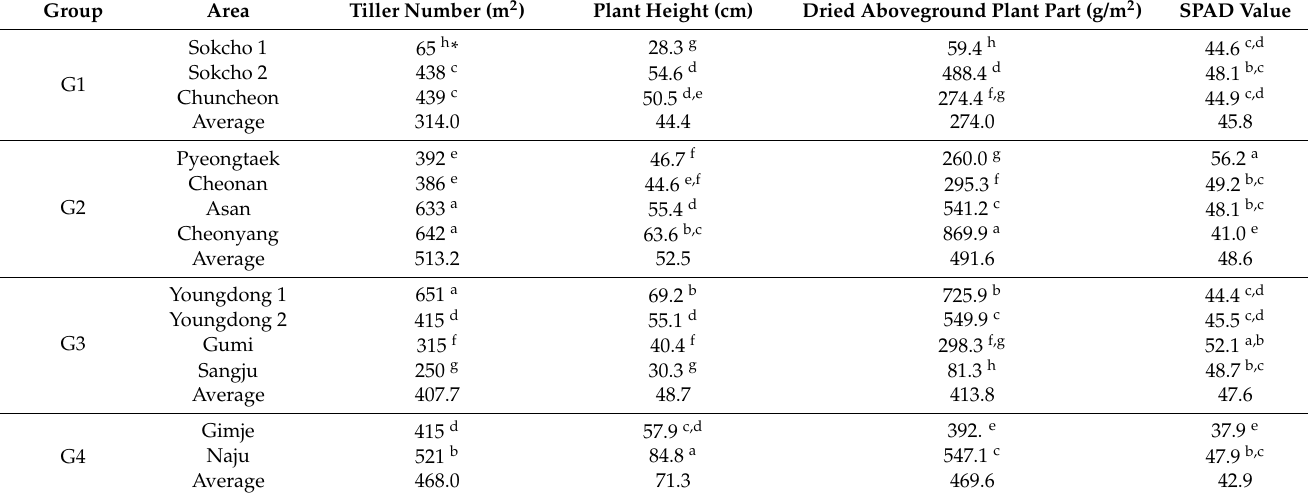
Table 3. Growth and chlorophyll contents (SPAD value) of dehulled barley plants in different group areas at heading stage (April).